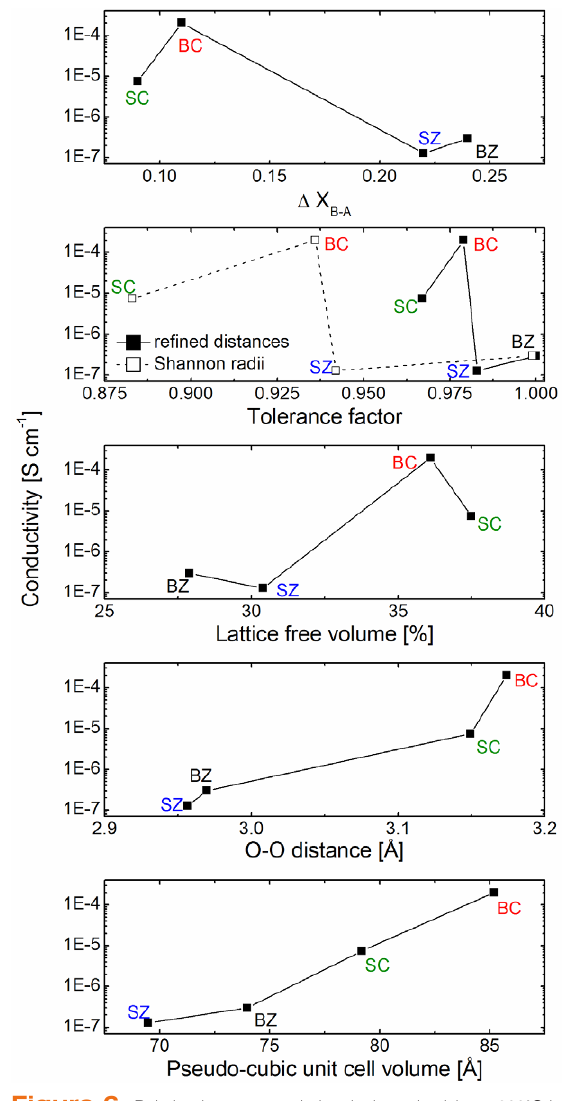
Figure 6. Relation between total electrical conductivity at 300°C in humidified air and difference between weighted Allred- Rochow electronegativities of B and A-site cations ( Δ X tolerance factor, lattice free volume, average distance between adjacent oxide ions (O-O distance), and pseudo-cubic unit cell volume. BZ = BaZr